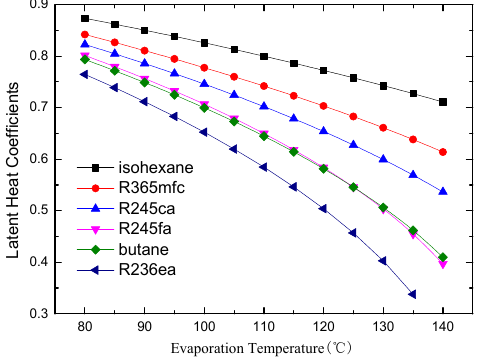
Figure 6. Latent heat coefficients of different working fluids.